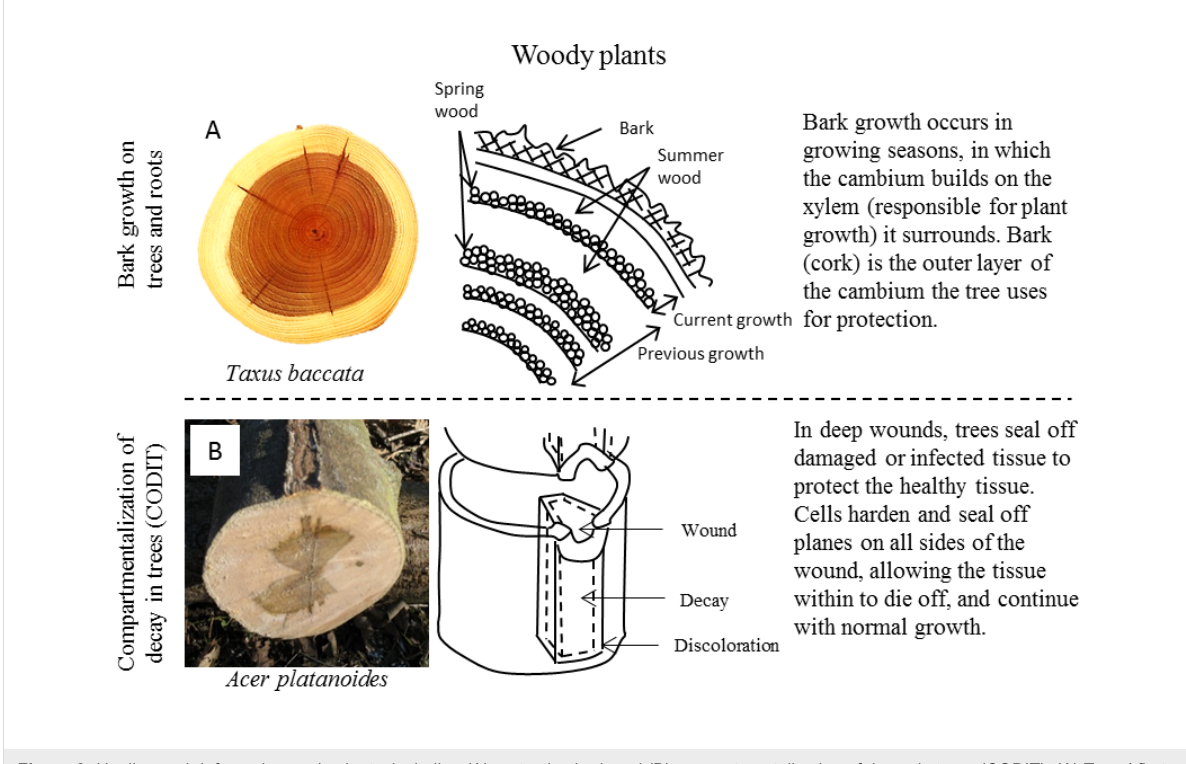
Figure 8: Healing and defense in woody plants, including (A) protective bark and (B) compartmentalization of decay in trees (CODIT). (A) Trees’ first line of defense is the hard outer bark that prevents physical damage from reaching the softer inner tissue. Left image reproduced from [75],